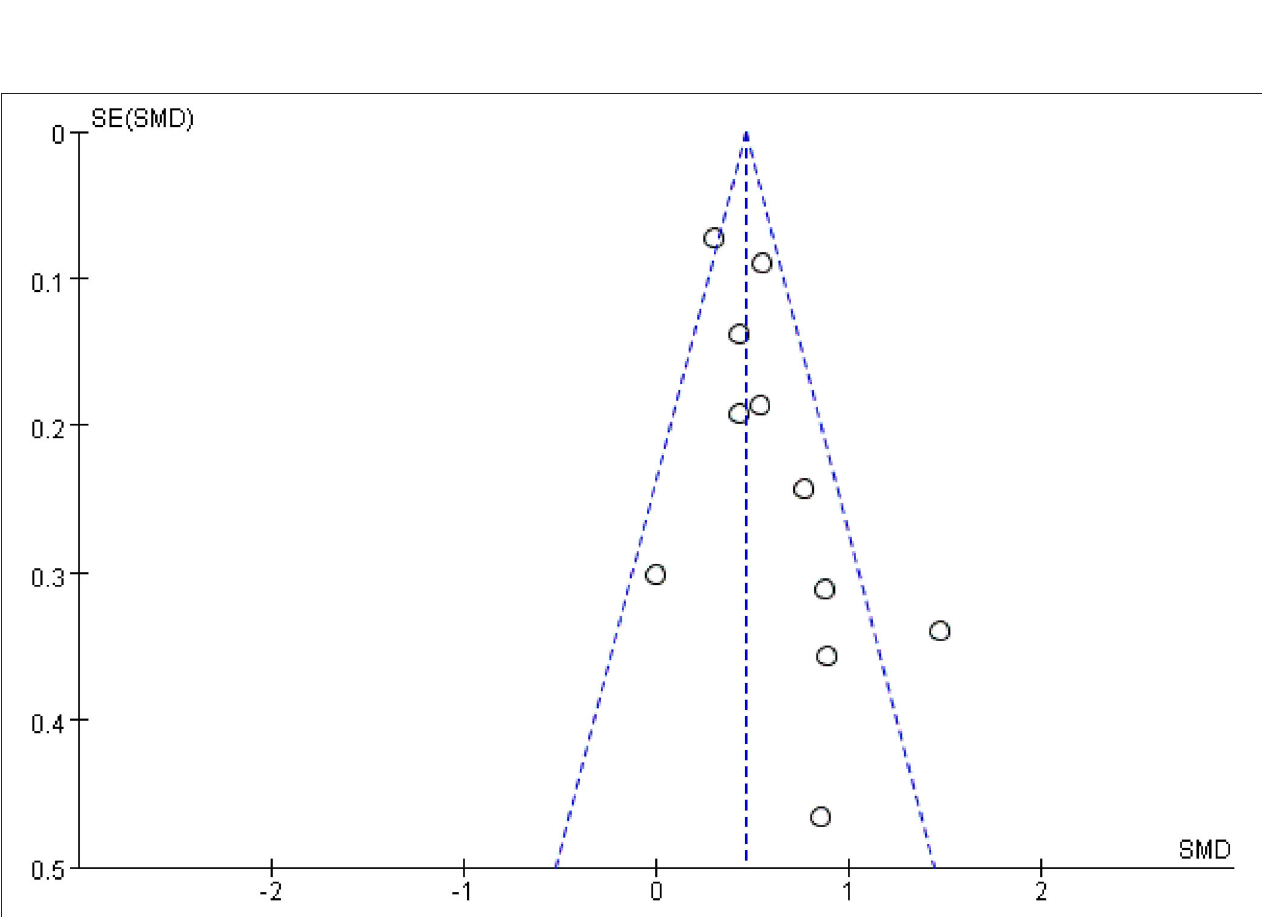
FIGURE 5 | Establish publication bias with funnel plot regarding to all publications.